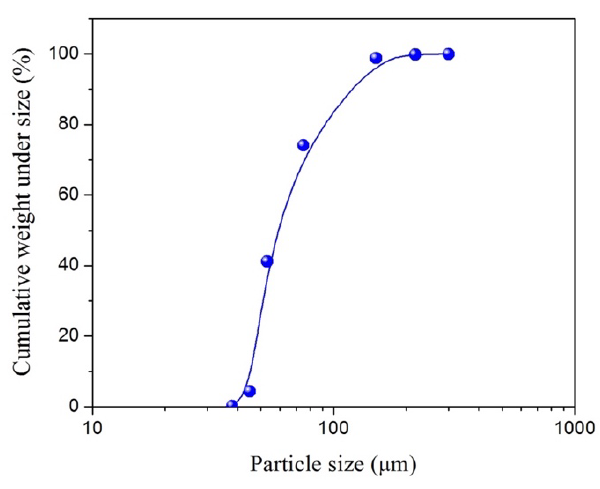
Figure 3. Particle size analysis of the gold–silver tailing sample.